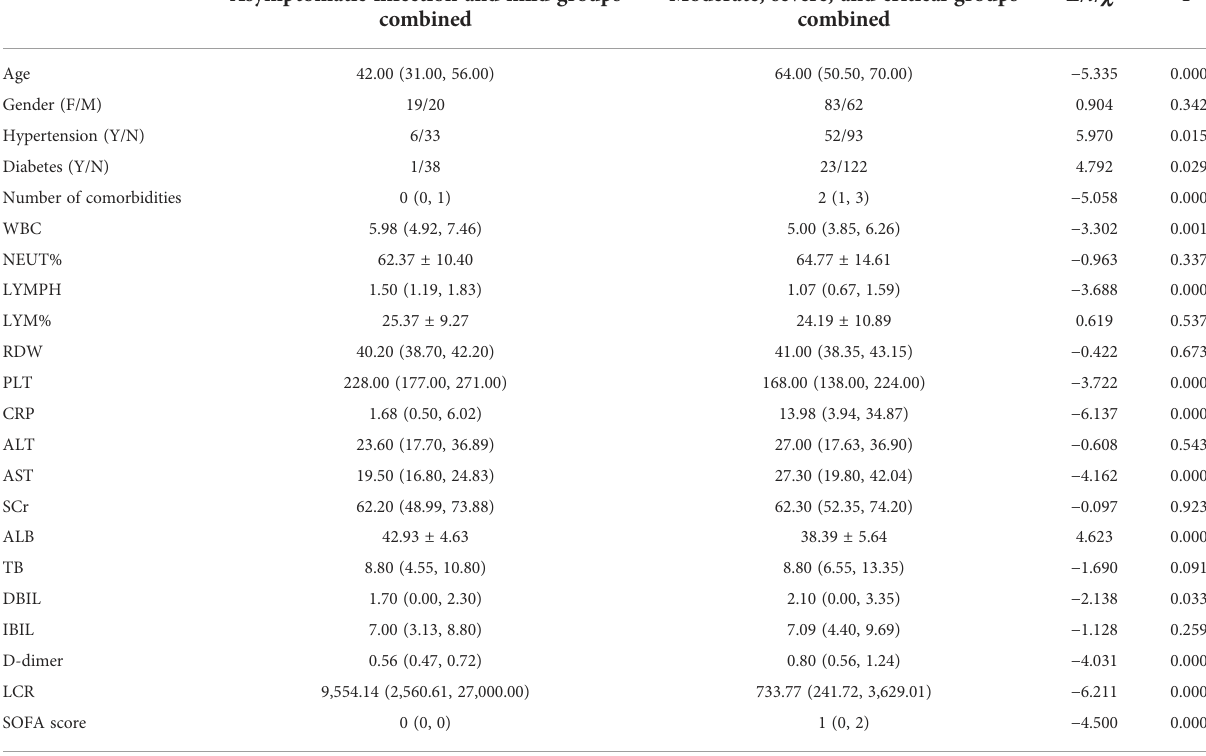
TABLE 2 Comparison of demographic and clinical baseline data between asymptomatic infection and mild groups combined and moderate, severe, and critical groups combined. Asymptomatic infection and mild